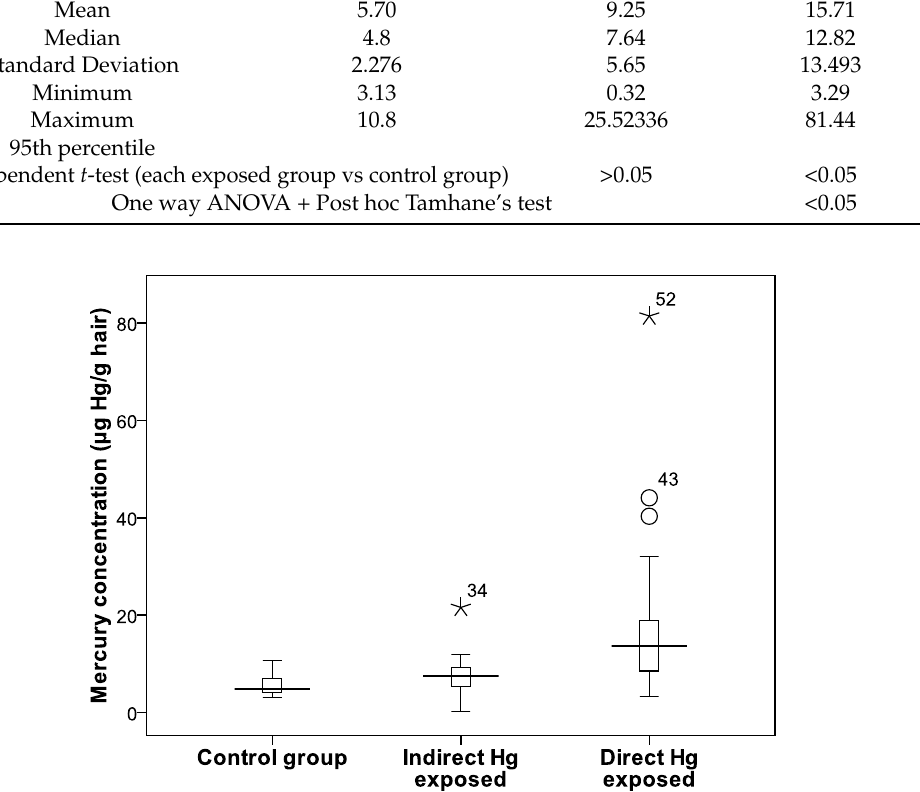
Figure 3. Box plot of mercury concentration in hair, significant different between each exposed group and control group (independent t -test; p < 0.05).